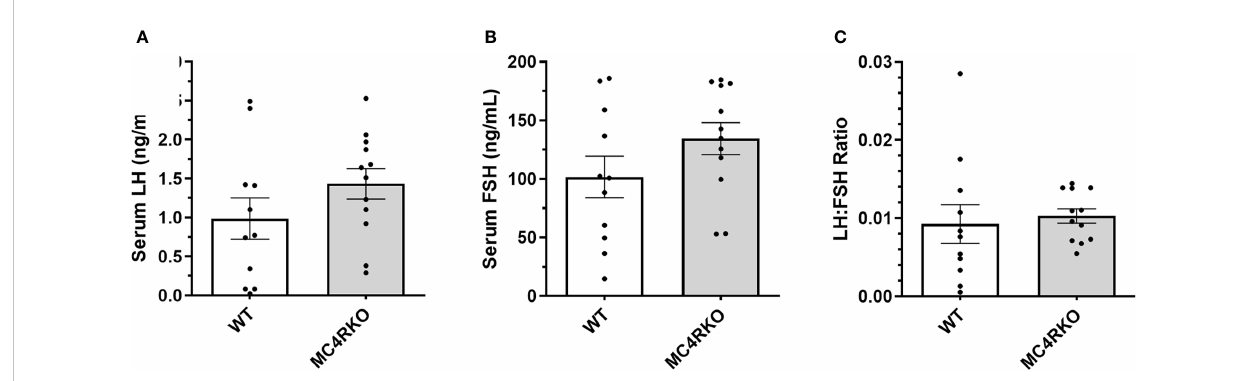
FIGURE 7 Serum LH and FSH concentrations were not different between groups. LH (A) and FSH (B) are represented separately as well as in the form of an LH : FSH ratio (C) for WT (n=11) and MC4RKO (n=12). Unpaired t-tests were used for graphs A and B. Unpaired Welch ’ s t-test was used for Graph